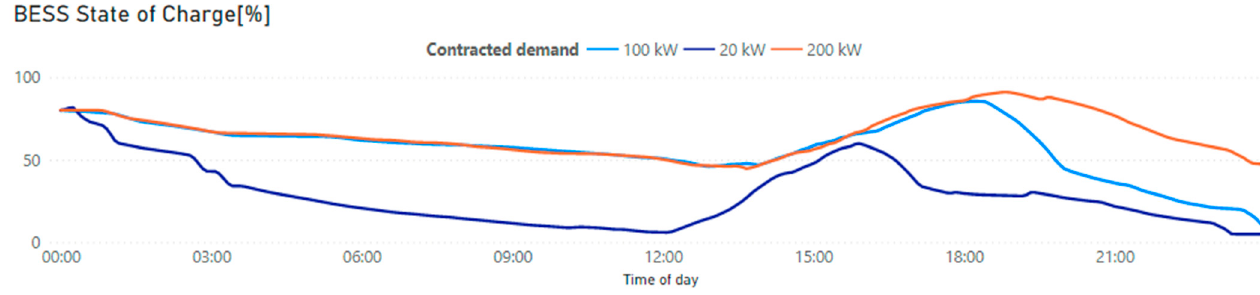
Figure 12. Variation in the state of charge for each contracted demand.